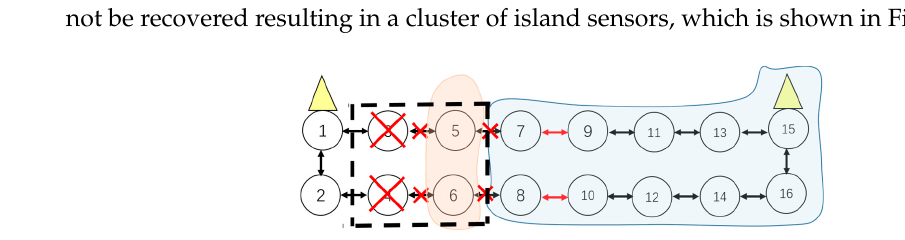
Figure 10. An island sensor situation.